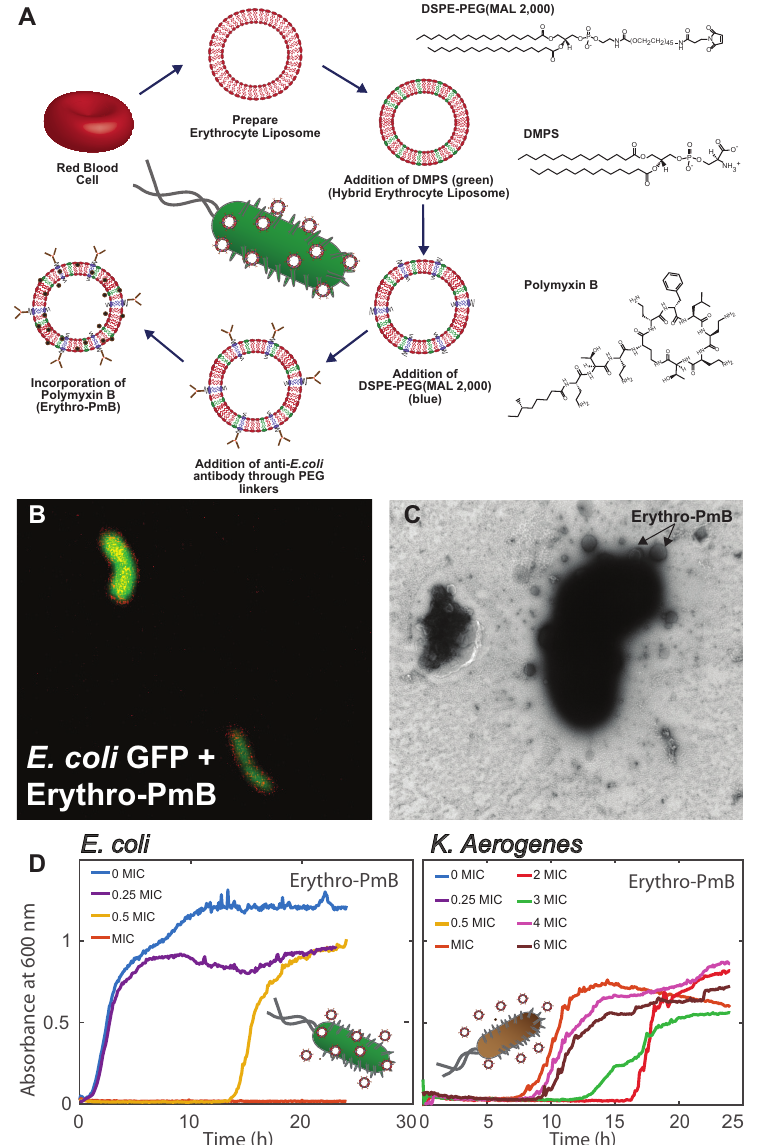
Figure 4. ( A ) Preparation schematic for Erythro-PmBs: Erythrocyte liposomes were prepared from red blood cells. Negatively charged lipids were added to enhance PmB retention. Anti- Escherichia coli ( E. coli ) antibodies are conjugated to malemeide residues on PEG linkers. ( B ) Fluorescent microscopy image of Erythro-PmBs stained with TR-DHPE (red) targeting E. coli expressing green fluorescent protein (GFP, green). ( C ) Erythro-PmBs form attachments with E. coli in transmission electron microscopy. ( D ) E. coli , ( left ) and Klebsiella aerogenes ( K. aerogenes , ( right )) are treated with Erythro- PmBs delivering varying concentrations of the minimum inhibitory concentration (MIC) for free PmB. Bacterial growth curves show Erythro-PmBs prevent E. coli growth with high efficacy; however, are not active against K. aerogenes . Figure adapted from